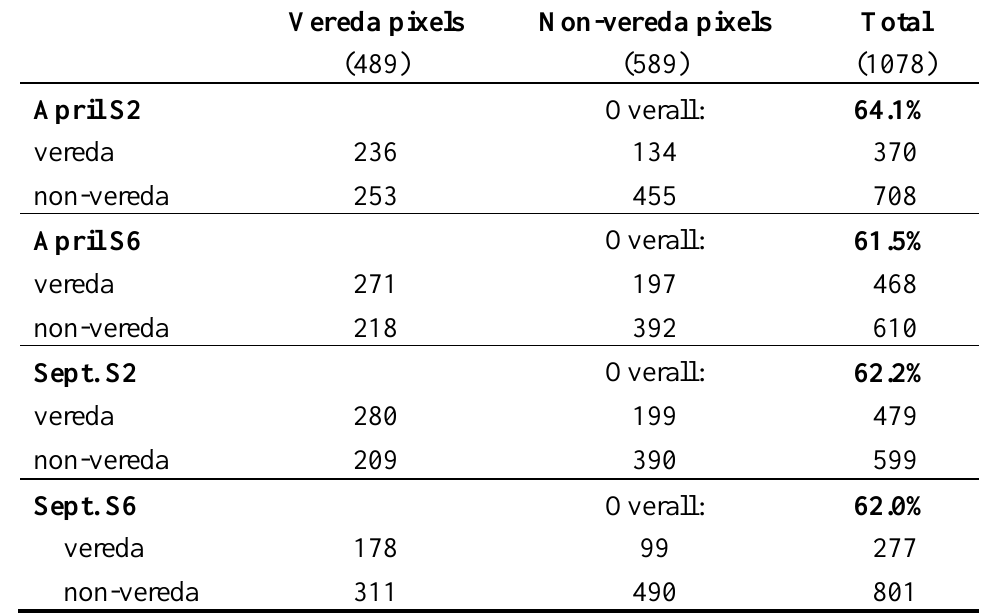
Table 3 . Confusion matrices and overall success for the classification of the four Radarsat- 1 images into vereda (including grassland) and non- vereda .